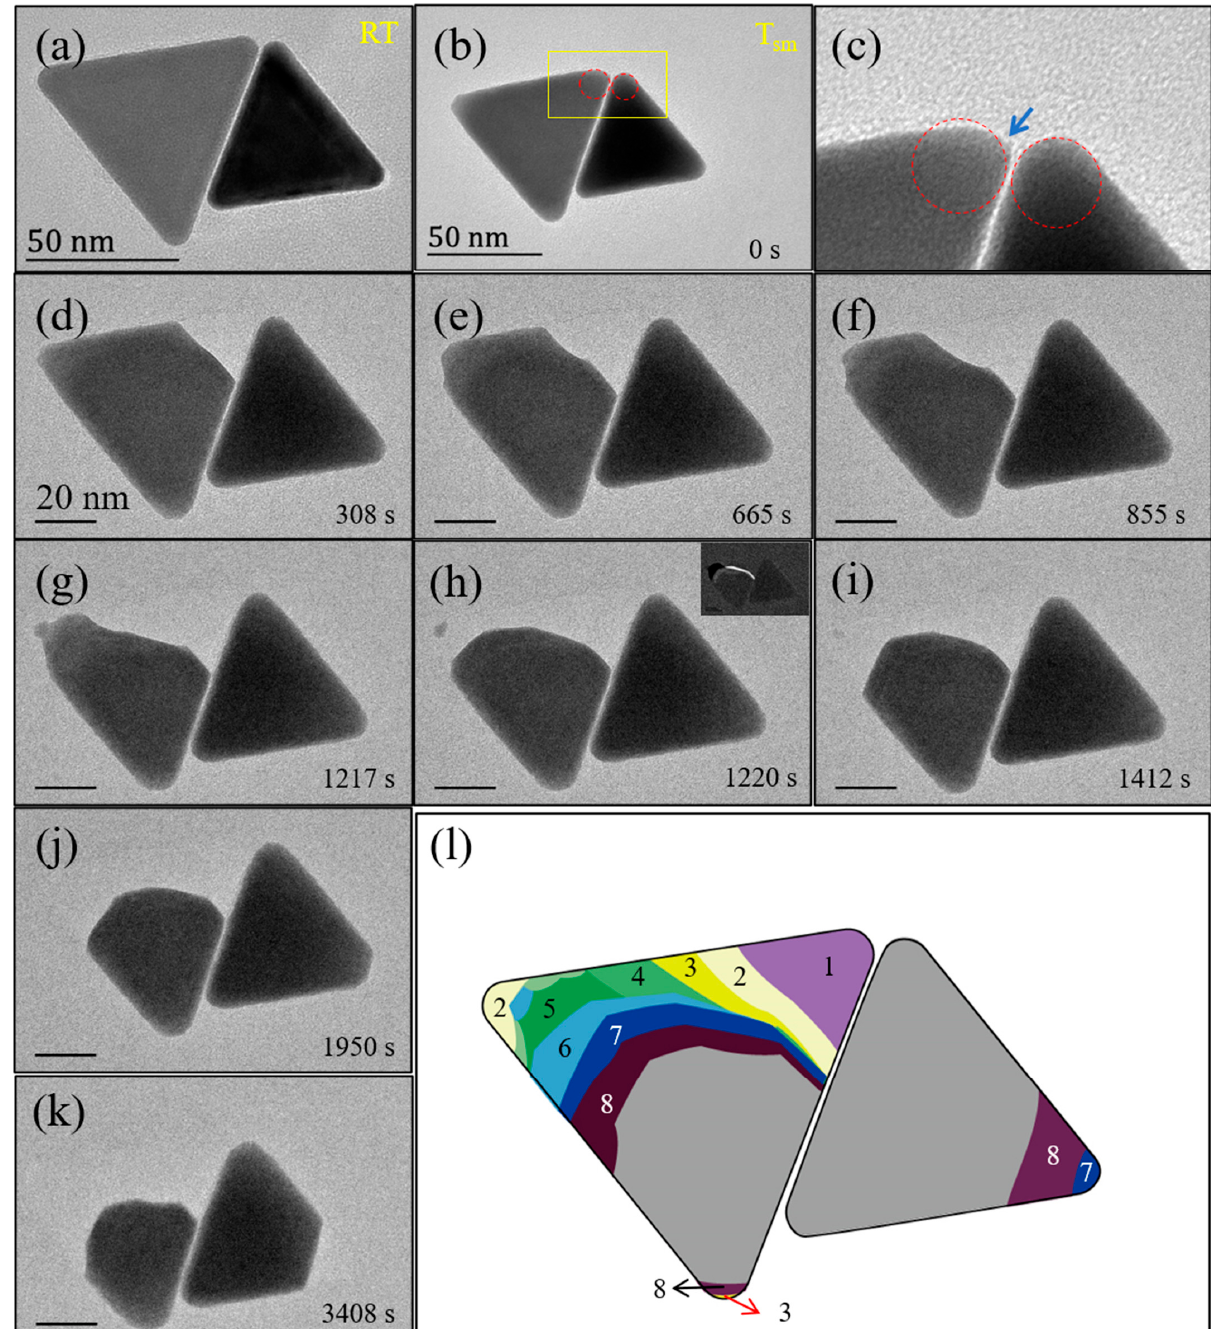
Figure 3. Thermal stability and evaporation pathways of aggregated Au nanoprisms without direct contact. ( a ) TEM image recorded at RT. ( b , d – k ) Sequential TEM images recorded at 0, 308, 665, 855, 1217, 1220, 1412, 1950, and 3408 s, respectively, after the sample was heated to a quasi-melting state (Tsm). The inset to ( h ) shows a difference image obtained by subtracting ( h ) from ( g ). ( c ) A large view of the image region as marked in ( b ). The arrow indicates sharp intersection between flat and spherical surfaces. ( l ) A contour display for the temporal shape changes of the nanoprism at the heating times ( b , d – k ). The numbers 1–8 correspond to the shape changes in ( d – k ), respectively. Scale bars for ( d – k ): 20